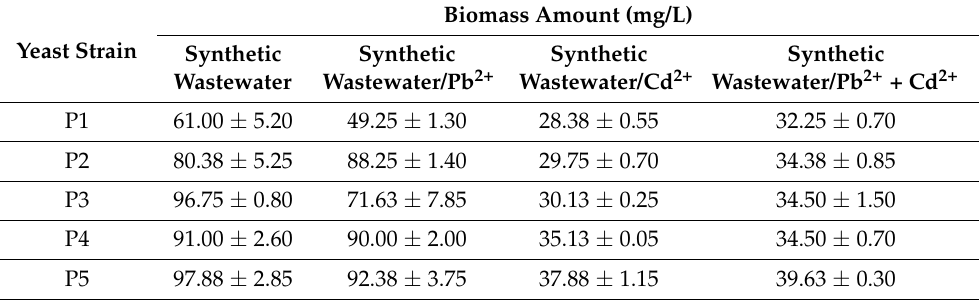
Table 2. The amount of yeast biomass at the end of the experiment. Yeast Strain